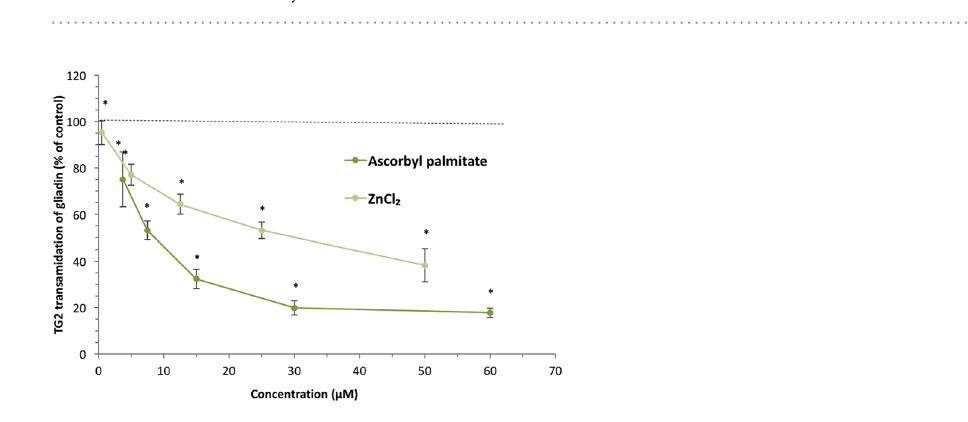
Figure 4. TG2-mediated transamidation of wheat gliadin (to biotin) in the presence of selected ligands at 15 µ M (reported in Table 1) shown as percentage of gliadin control. Data are presented as means ± SD (n = 3). The asterisk indicates a significant change (p < 0.05) from control. Only ascorbyl palmitate was able to reduce the transamidation to a major extent.